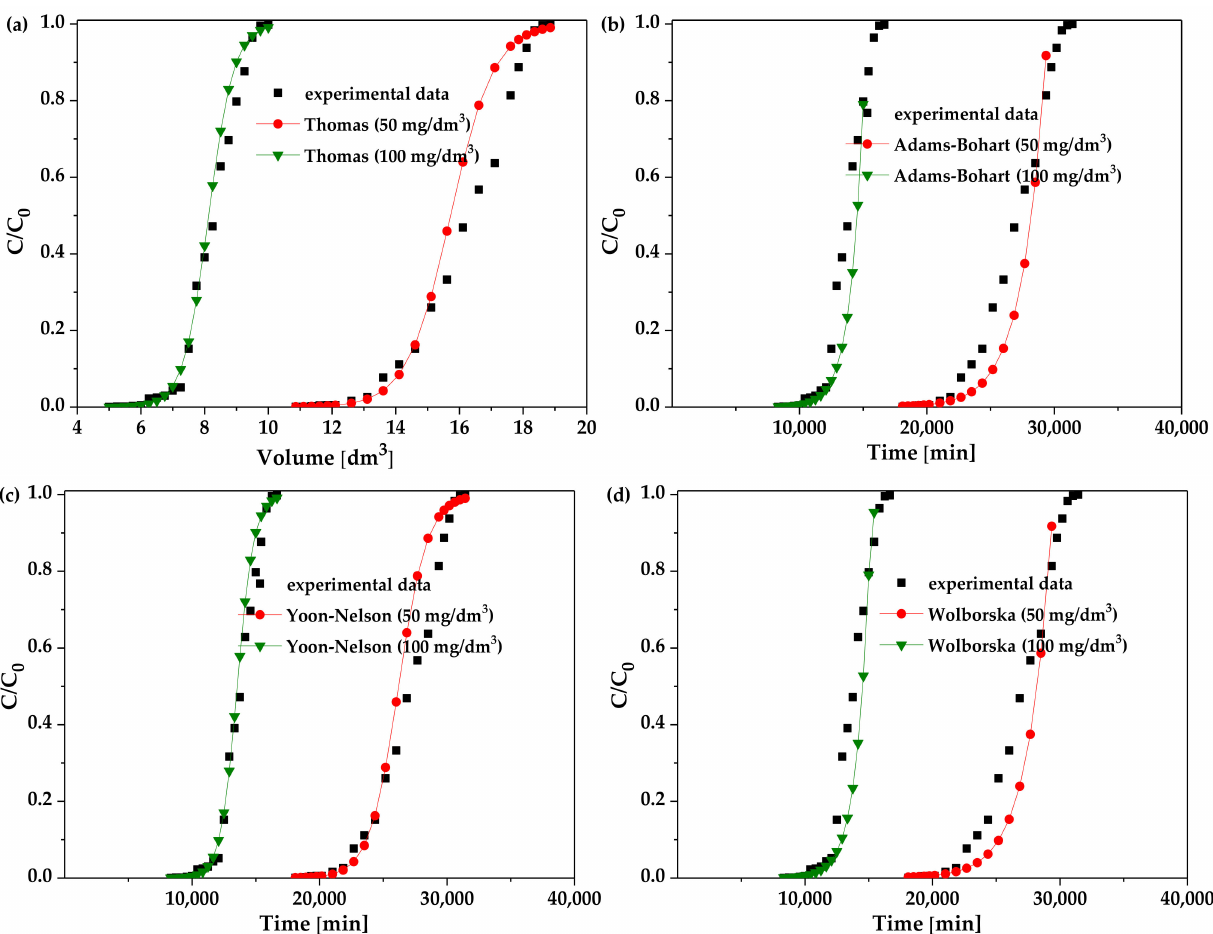
Figure 7. Fitting of nonlinear ( a ) Thomas, ( b ) Adams-Bohart, ( c ) Yoon-Nelson, and ( d ) Wolborska models to the experimental data from the La(III) adsorption in the fixed-bed column studies for the alginate-biochar